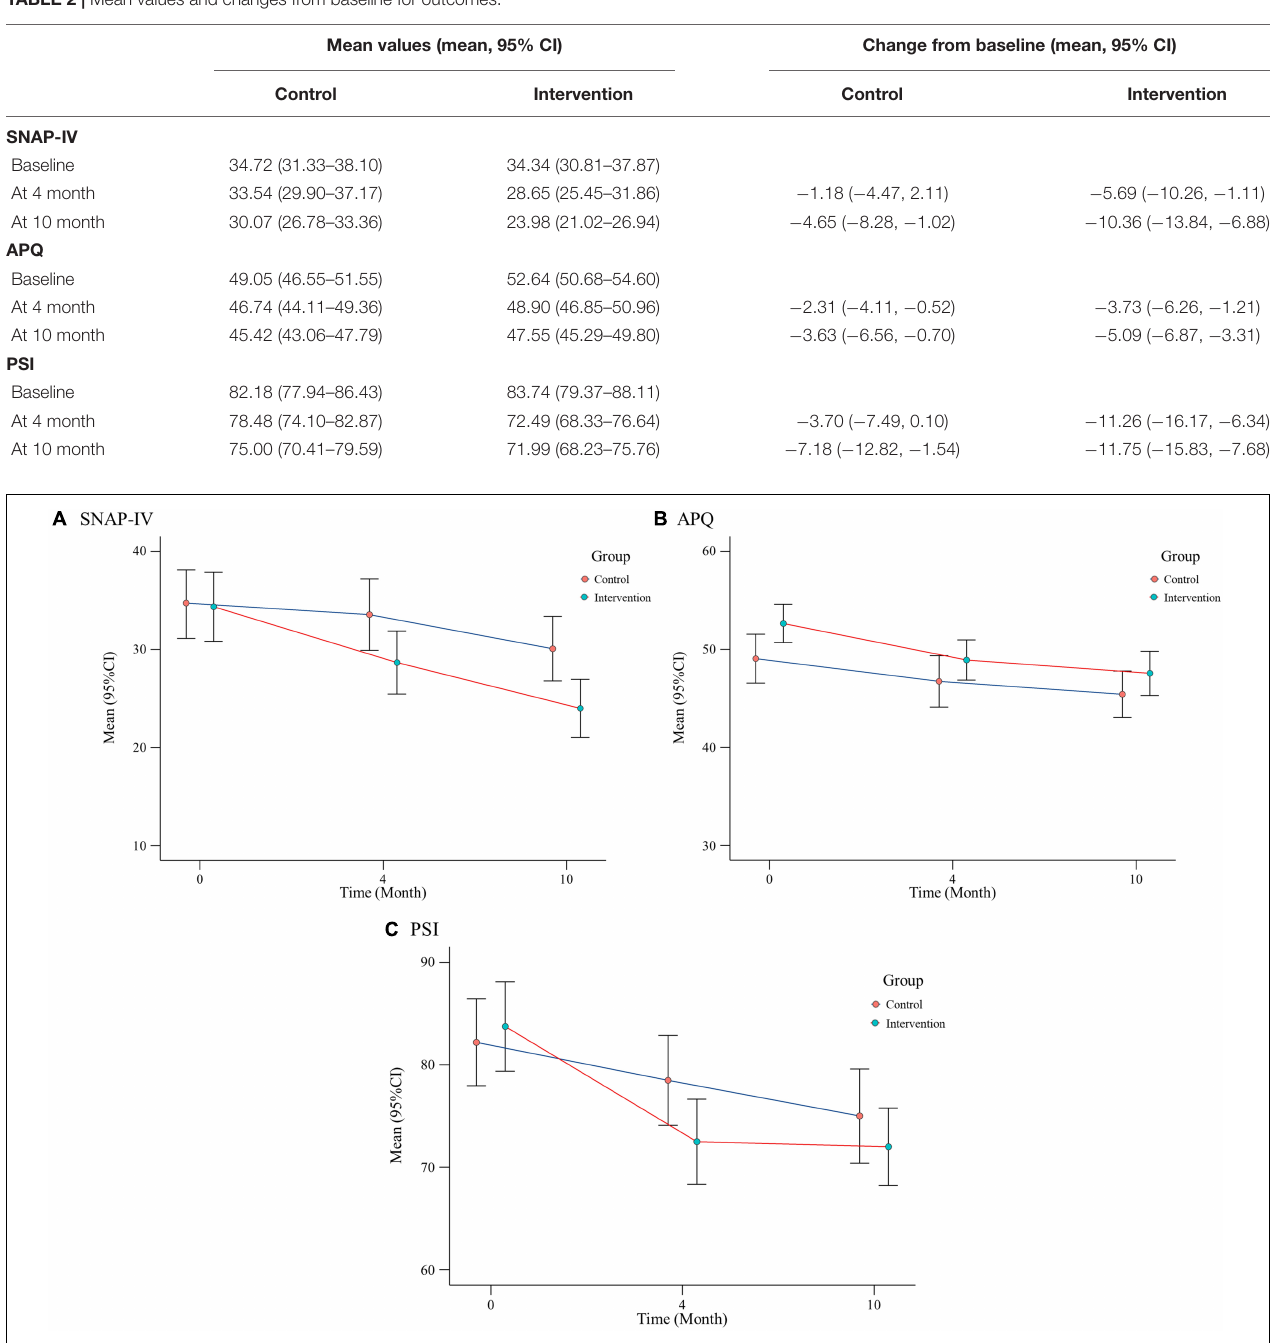
FIGURE 2 | Effects of interventions over time: changes in SNAP-IV, APQ, and PSI in two groups of participants at different visit points.